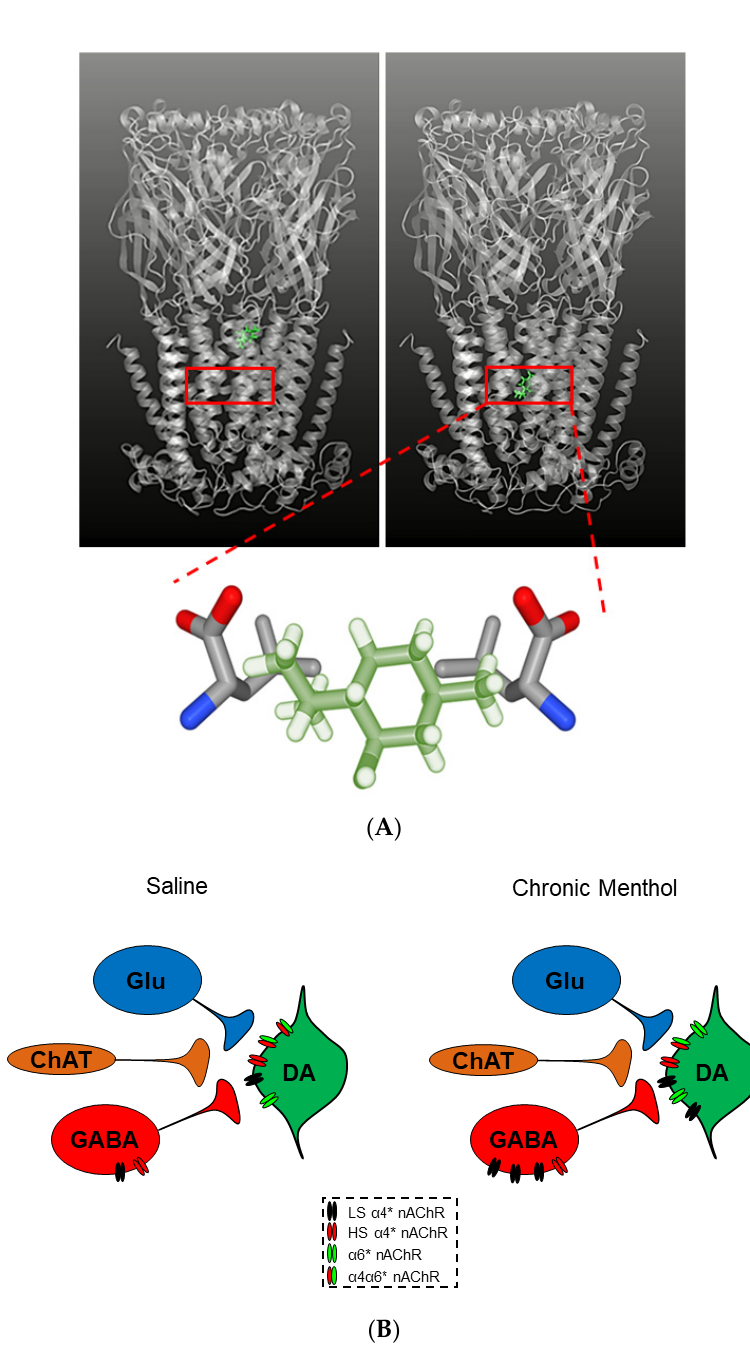
Figure 4. Menthol binding patterns and mechanisms of action. ( A ) Top panel: Menthol molecule (in green) binding in the transmembrane 2 (M2) helix lining the central pore of the nAChR. Bottom panel: A closer look at menthol binding within the 9 ′ leucine residues of the M2 helix of the nAChR. ( B ) Compared to saline, menthol induces upregulation of low-sensitivity (LS) α 4* nAChRs on VTA GABA neurons (in red) and α 4* (LS) and α 6* nAChRs on VTA dopamine neurons (in green). This results in reduced neuronal firing based on the desensitization properties of the nAChRs, with a net excitatory effect of VTA dopamine release. * = nAChR may contain other subunits.